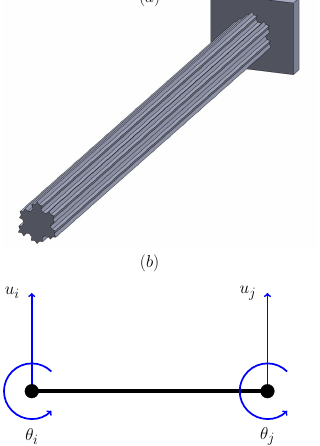
Figure 1. Cantilever beam. ( a ) With cross section type classical Koch snowflake and ( b ) beam element